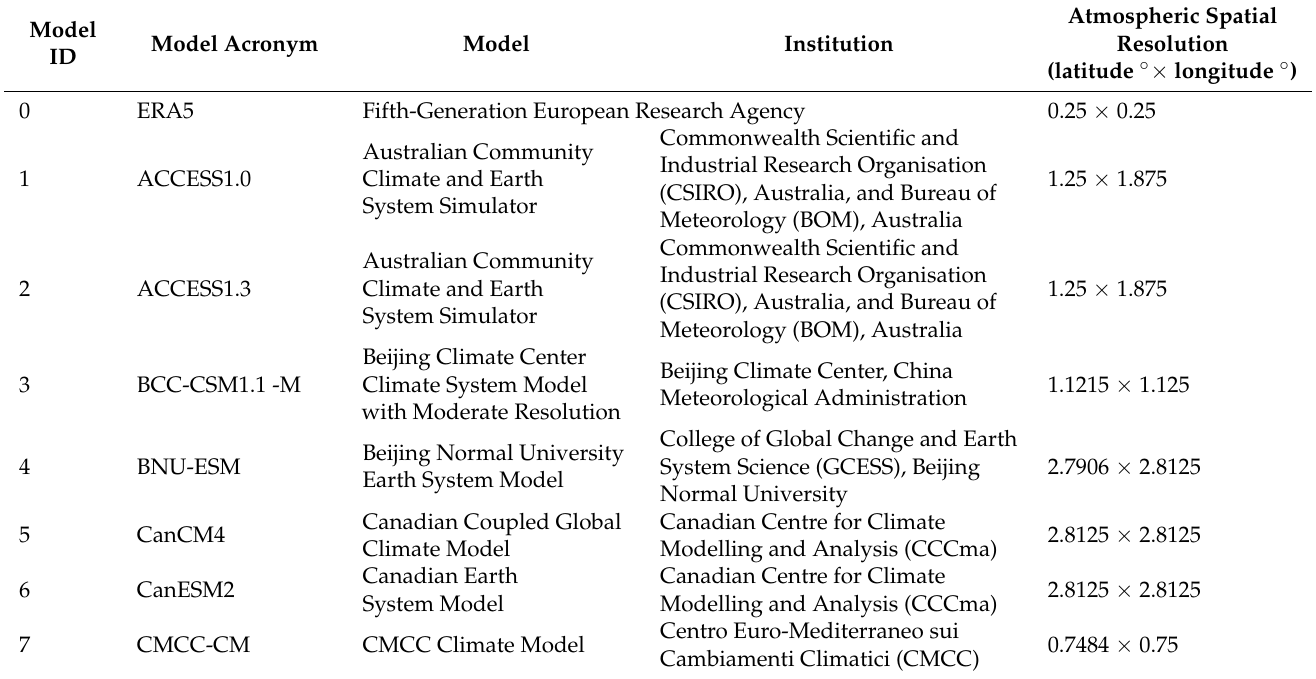
Table 1. Attributes of CMIP5 GCMs and